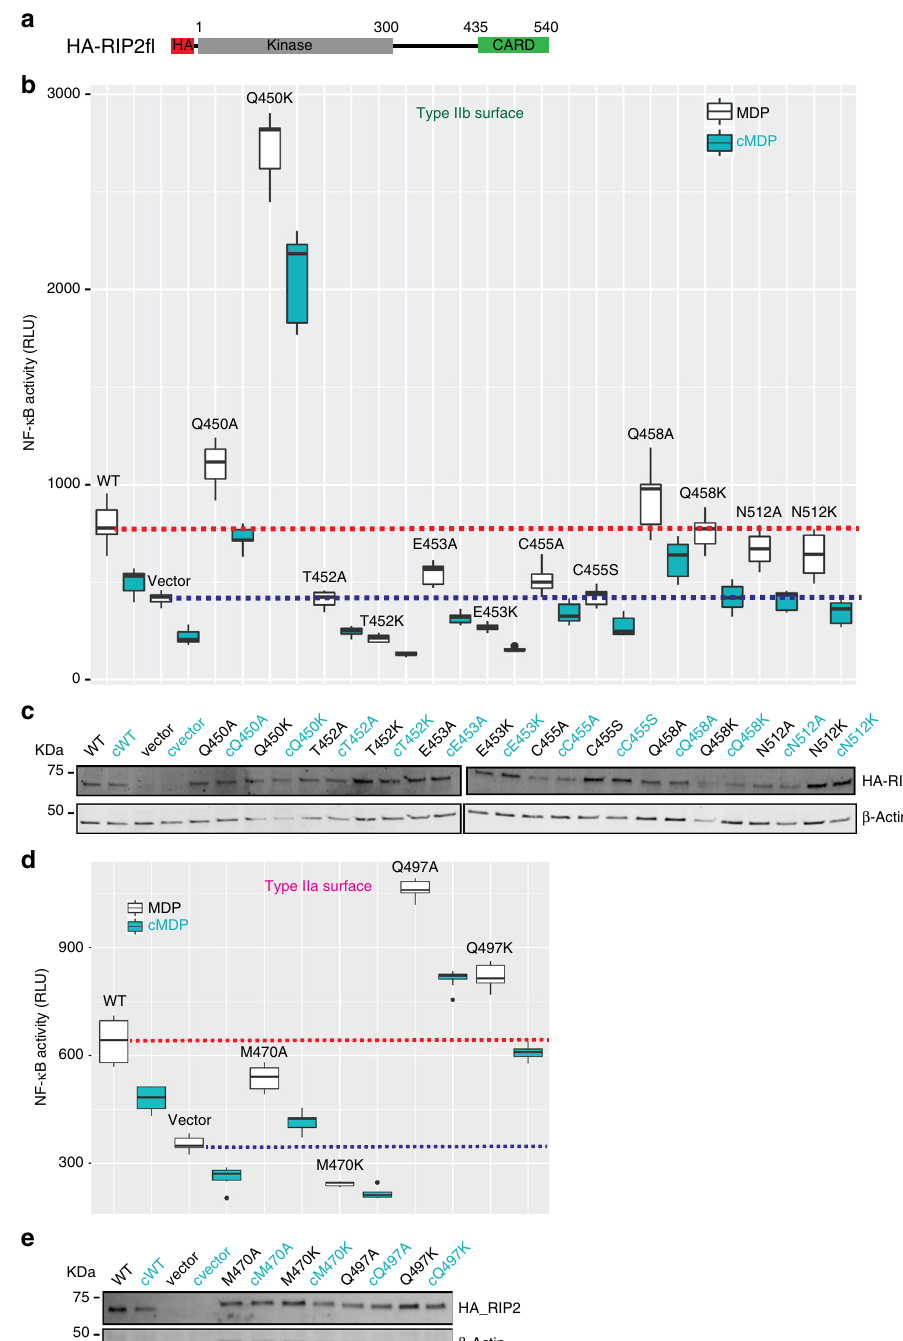
Fig. 9 Effect of type II surface mutations on NOD2 dependent NF- κ B signalling. a Domain organization of the HA-RIP2 fl construct used for the luciferase reporter assay. b , d Luciferase reporter assay in HEK293T cells showing the effect on NF- κ B signalling of transfected WT and mutant RIP2 fl for ( b ) type IIb surface and ( d ) type IIa surface. Each MDP value is signi fi cantly higher than that using c MDP. Average RLU values for WT RIP2 fl -MDP and control-MDP are shown by dashed red and blue lines, respectively. The boxplot is the graphical representation of the summary statistics of a vector contains information in this order: minimum value (lower whisker), fi rst quartile (25% of data lower bound box), median (50% of data centre line), third quartile (75% of data higher bound box) and maximum value (upper whisker). Black dots on boxplot are extreme values. c , e Example WB for ( c ) type IIb surface mutants and ( e ) type IIa surface mutants, showing expression of wild-type (WT) HA-RIP2 fl and mutants (top) and β -actin (bottom). For each construct, the results for cells induced by either MDP or its control (cMDP, c ) are reported in black and cyan show high levels of auto-activation compared with the wild-type (Fig. 9b, d). The less drastic alanine mutants T452A, E453A, RIP2 (Fig. 9b, d). In contrast, T452K, E453K, C455S and M470K C455A and M470A also showed lower or zero activity (Fig. 9b, d). failed to transmit the signal from NOD2 to NF- κ B, as the All the mutants show similar protein expression to wt RIP2 luciferase value is equal or lower than the control empty vector (Fig. 9c, e and Supplementary Figure 12).